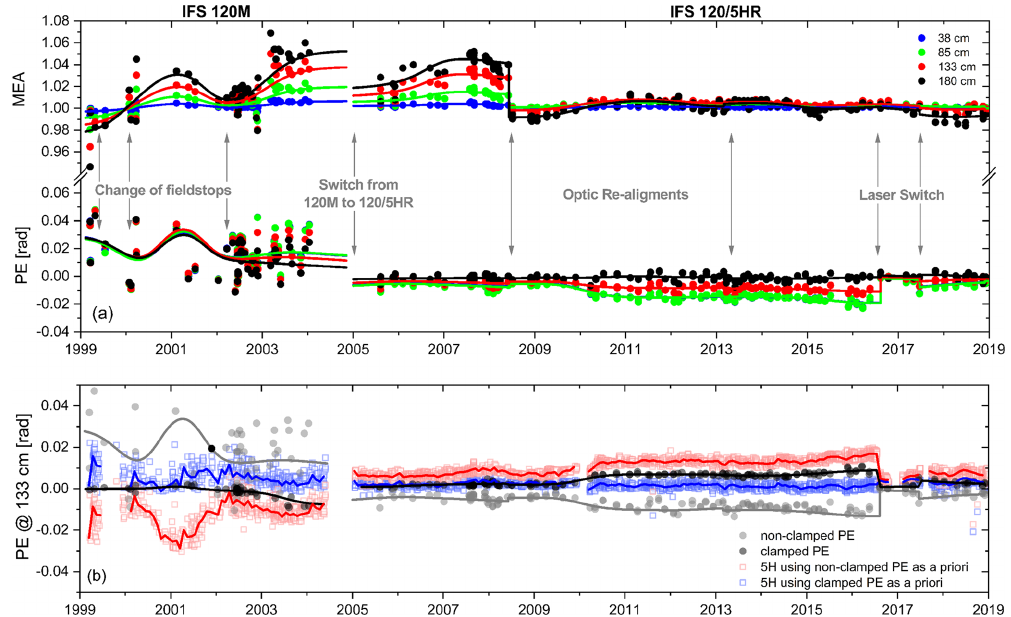
Figure A1. (a) Time series of the normalized MEA and PE values at four OPDs (38, 85, 133, and 180cm) between 1999 and 2018. Data points represent individual N 2 O cell measurements, and solid lines depict the smoothed MEA and PE curves. The solid grey arrows indicate punctual interventions made regarding the IZO FTIR instruments: changes in the field stop instruments between 1999 and 2004, the switch from the IFS 120M to the IFS 120/5HR in January 2005, optical re-alignments in June 2008 and February 2013, and internal laser replacements in August 2016 and June 2017. (b) Time series of the PE values at an OPD of 133cm (including the non-clamped and clamped PE retrieval at ZPD) and the time series of the retrieved PE values from the O 3 retrievals using the 5H set-up (including the non-clamped and clamped PE retrievals as a priori information). Note that the retrieved PE from the 5H set-ups is constant throughout the whole OPD range.